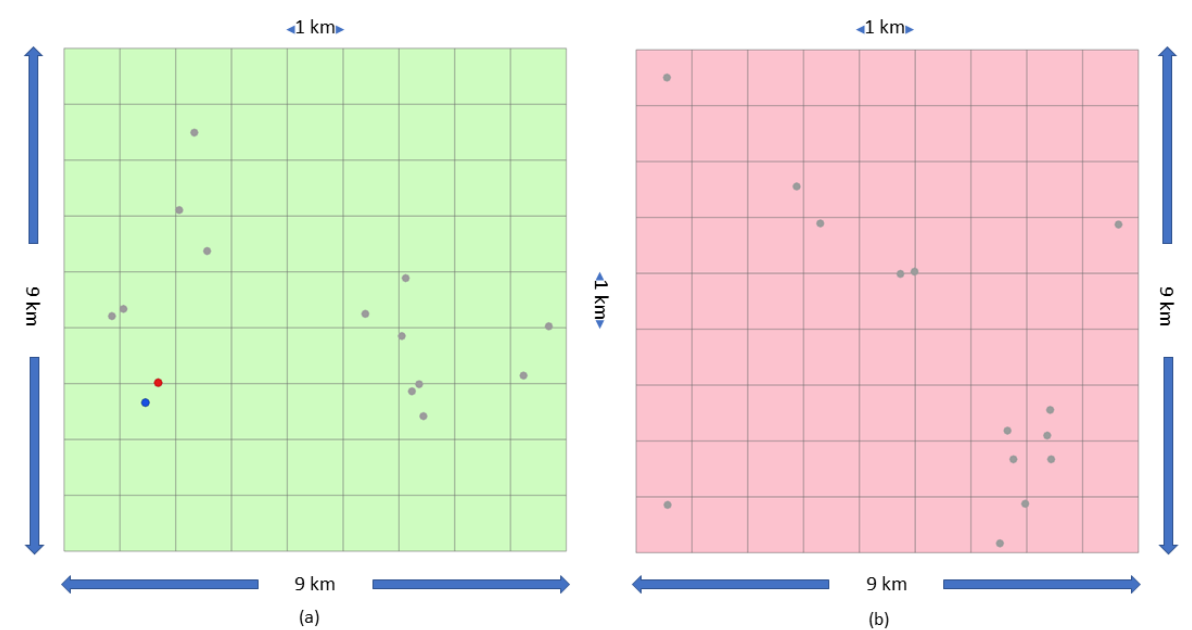
Figure 4. A comparison between two scenarios: spatial autocorrelation detectable versus non-detectable in the soil moisture network. ( a ) Scenario a shows spatial autocorrelation detected in grid 2, the outlier stations detected by the local Moran’s I are represented in red and blue colors, where red represents a high–low (HL) outlier, blue represents a low–high (LH) outlier, and normal stations are shown in gray color; ( b ) scenario b shows spatial autocorrelation not detected in grid 11, and the normal stations are shown in gray color. Figure 4a shows an example from a single day (01 July 2018 06:00); for a completed spatial autocorrelation detected in the data, see Figure A1 in the Appendix A. Semivariogram is another method to depict the spatial autocorrelation of the meas- ured samples by computing and plotting the variance between any pair of soil moisture observations, and a model is then fit through them. Grid 2 is the case of detectable spatial